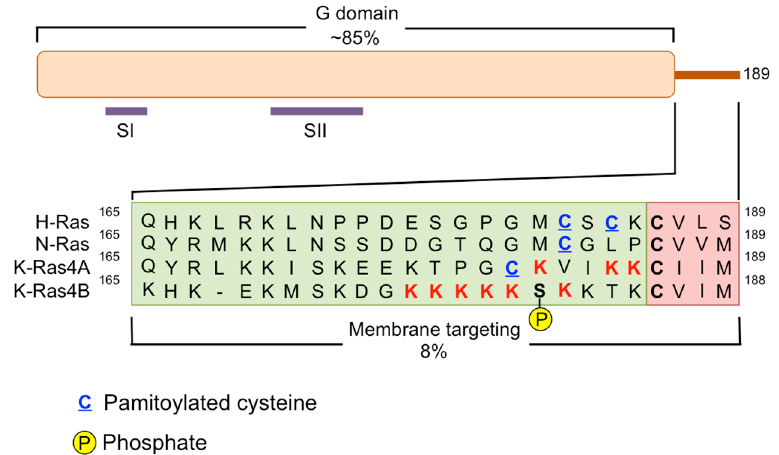
Figure 1. Human RAS proteins are composed two functional domains, the G domain and the membrane targeting domain. The G domain spans residues 1–164 and includes the regions of the protein responsible for binding and hydrolyzing GTP. Specifically, residues in the switch I (SI = amino acids 30–38) region and switch II (SII = amino acids 60–76) region experience a conformational change during GDP-GTP cycling. The membrane targeting domain is comprised of the remaining 24/25 C-terminal residues. The first 20–21 amino acids are referred to as the hypervariable region and this is where the three RAS isoforms exhibit the greatest diversity in protein sequence. The hypervariable region contains elements important for membrane association including cysteines (blue, underlined) that are covalently modified by the addition of a palmitate fatty acid, and stretches of polybasic amino acids. Additionally KRAS4B contains a serine (181) that can be phosphorylated and regulates the association of this protein with the plasma membrane or endomembranes. The four most C-terminal residues of the membrane-targeting domain comprise the CAAX motif, where C = cysteine, A = any aliphatic residue, and X = the terminal amino acid. A C15 farnesyl group is covalently attached to the cysteine residue by farnesyltransferases and this lipid moiety aids in membrane association.